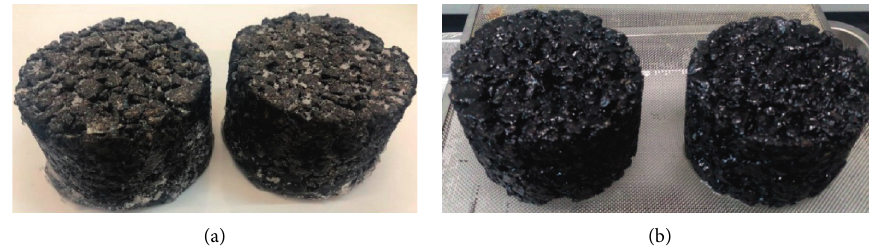
Figure 3: Process of freezing and thawing the test samples. Specimen appearance (a) after freezing and (b) after melting.